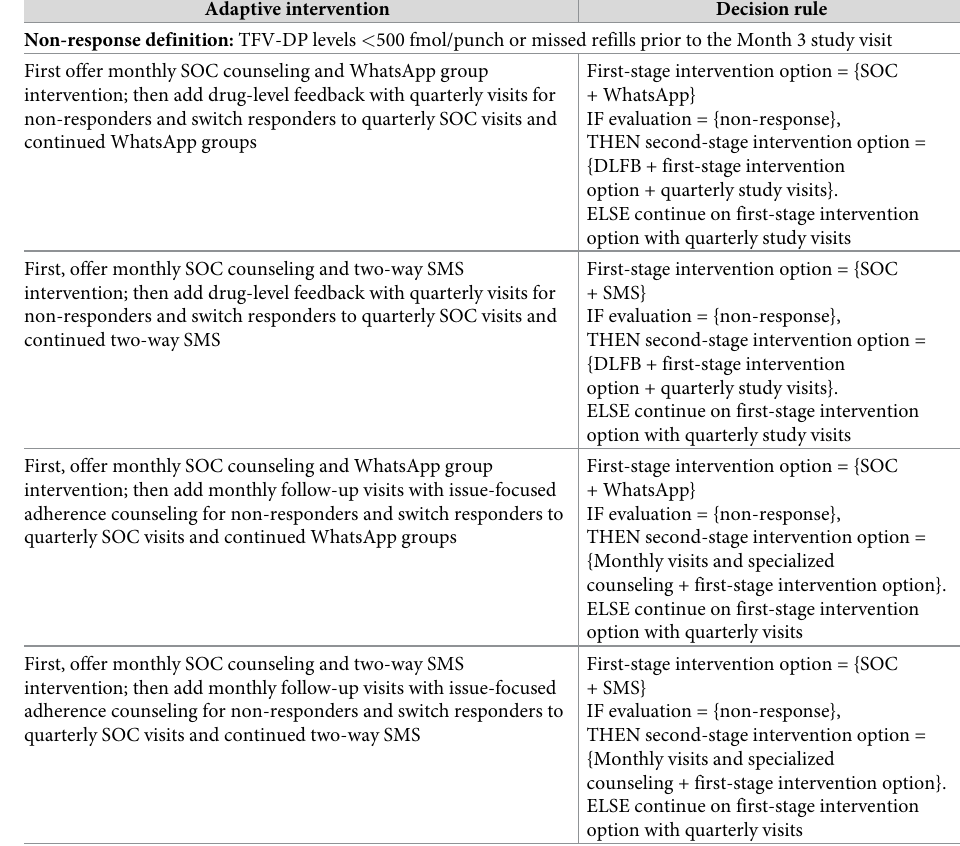
Table 2. Adaptive adherence support